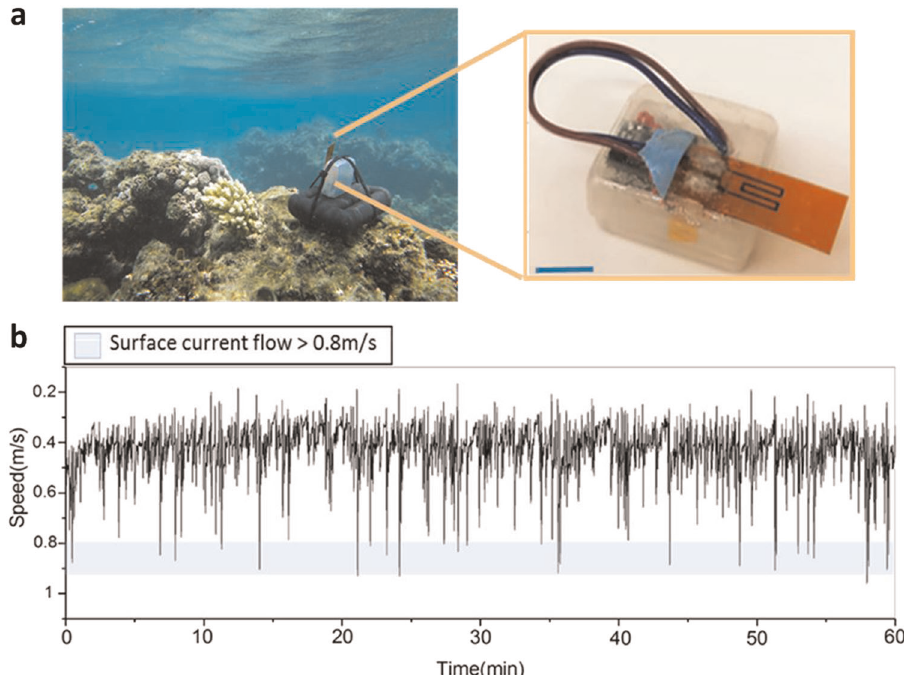
Fig. 12 a Tag deployment in Al Fahal Reef of Red sea to measure fl ow velocity. Inset shows the LIG bending sensor integrated with a Daily Diary tag (scale bar: 1 cm). b Recorded resistance as a function of time for a duration of 1